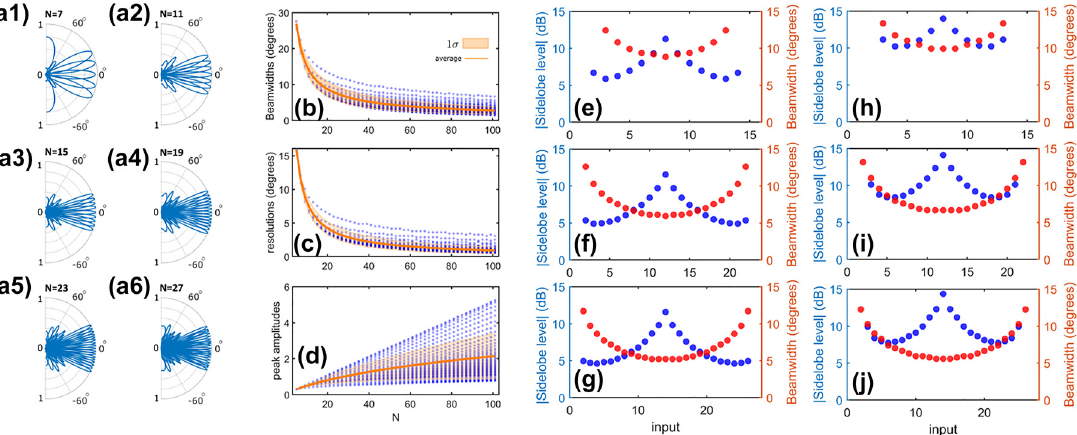
Figure 6: The scaling of the beam steering characteristics with the number of waveguides N . (a1–a6) The array factor for N = 7 , 11 , 15 , 19 , 23 and 27, for excitation from all channels, excluding the peripheral ones. (b, c) The scaling of the (b) beamwidth, (c) angle scanning resolution, and (d) beam peak amplitude with the size of the array. In (b, c), each dot represents excitation from one of the channels. (e, g) Sidelobe level and beamwidth for different excitation channels for array sizes of N = 15, 23, and 27. (h–j) Sidelobe level and beamwidth for different excitation channels when using multi-channel excitation for array sizes of N = 15, 23, and